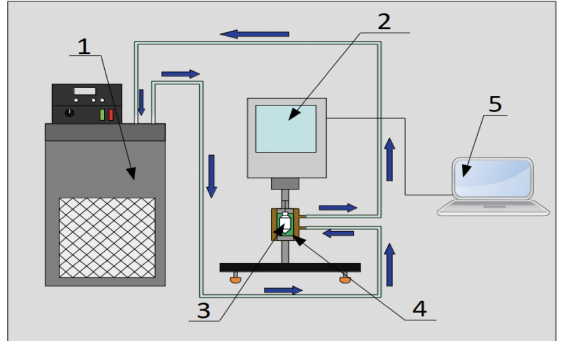
Figure 5. Experimental setup for viscosity conductivity measurement: (1) Refrigerated circulating bath, (2) Brookfield Viscometer model DV2T-LV, (3) spindle SC4-18, (4) sample and (5) computer with RheocalcT